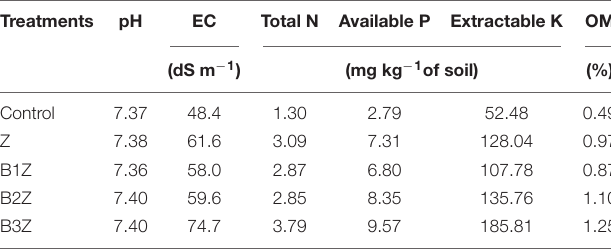
TABLE 4 | Mean of 2 years ( n = 3) soil pH, electrical conductivity (EC), total nitrogen (N), available phosphorous (P), extractable potassium (K), and organic matter (OM) of soil as influenced by the application of zeolite (Z) alone or in combination with biochar (B) applied at various doses.